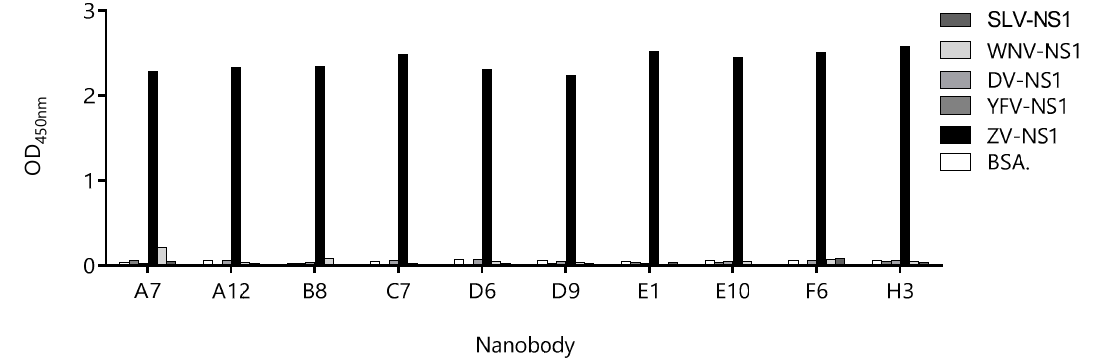
Figure 6. Evaluation of the cross-reactivity of the detection-nanobody candidates against different flavivirus NS1 proteins. Nanobodies were exposed to wells sensitized with 1.0 µg of NS1 from Zika Virus (ZV), Dengue Virus (DV), Yellow Fever Virus (YFV), West Nile Virus (WNV). Bovine serum albumin (BSA) was used as the negative control.